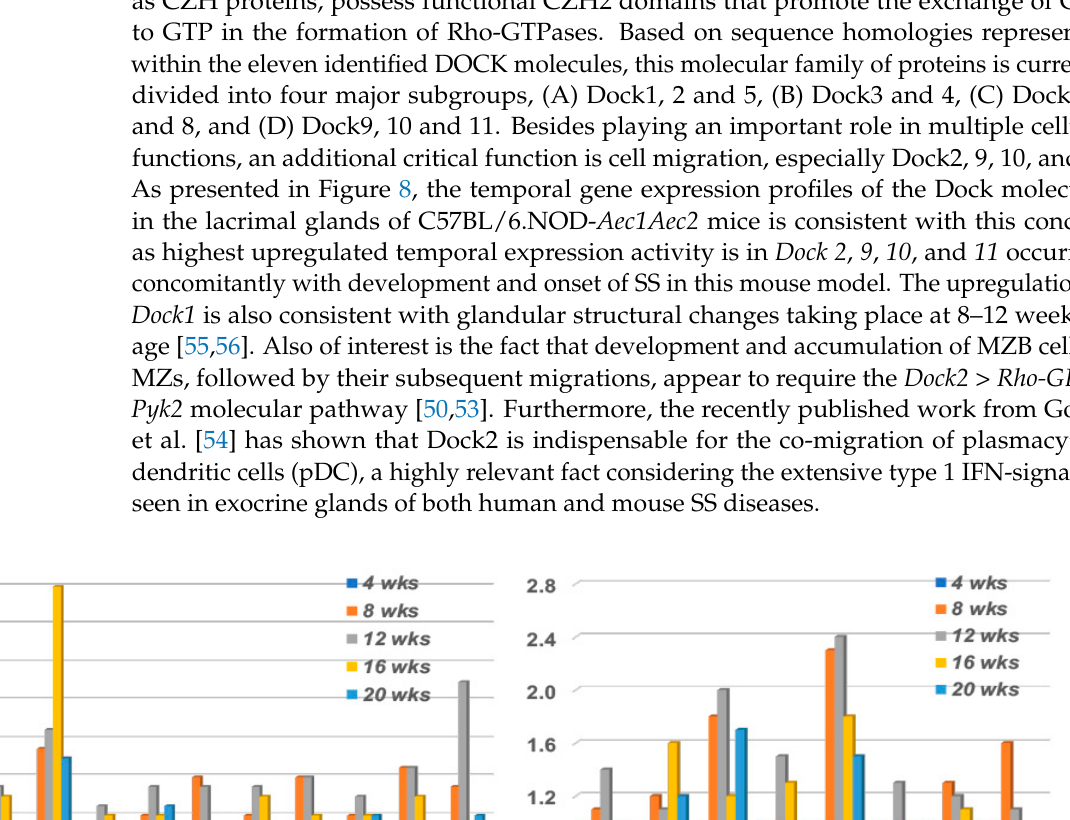
Figure 8. Temporal gene expressions for the Rho-GTP Dock gene family members . Transcriptome data showing the temporal expressions of the Dock genes upregulated in the lacrimal glands of C57BL/6.NOD- Aec1Aec2 mice. Two genes, Dock1 and Dock9 , exhibit an upregulated expression start- ing at 8 wks of age, while Dock2 , Dock10, and Dock11 exhibit an upregulated expression starting at 12 wks of age.